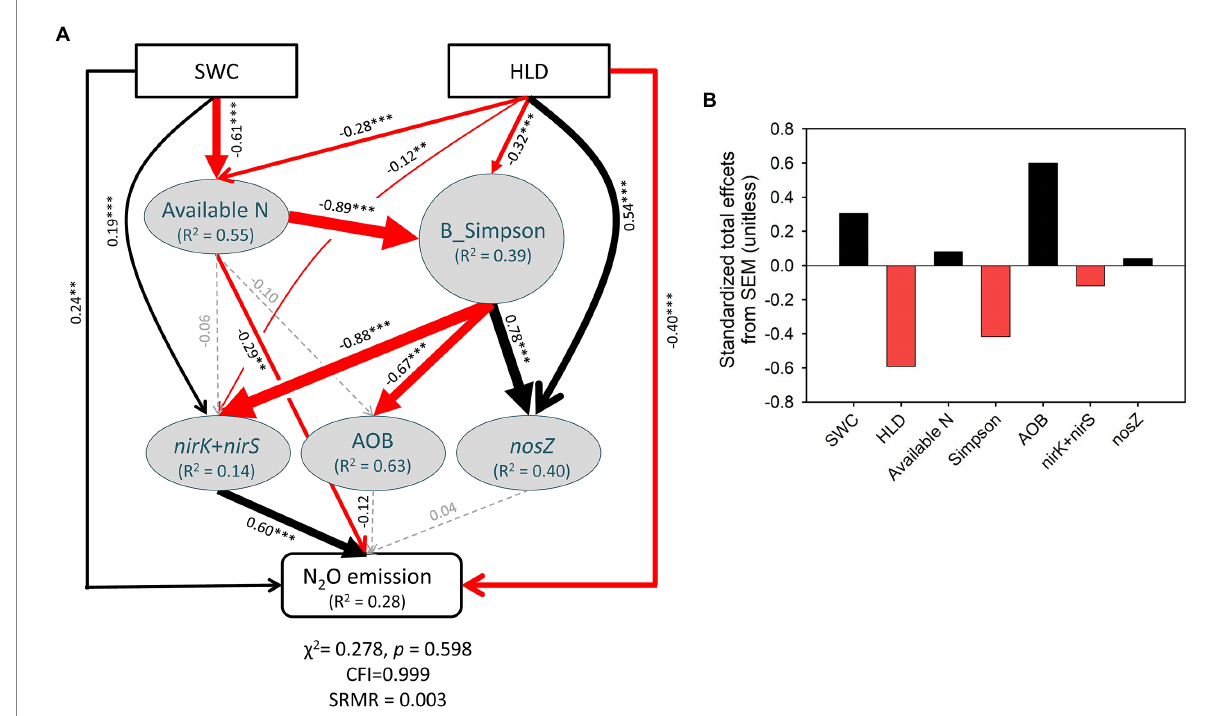
FIGURE 7 Structural equation modeling (SEM, A ) depicting the direct and indirect effects of soil water content (SWC) and hyphal length density (HLD) on the N 2 O emission of soil, and standardized total effects (direct plus indirect effects, B ) of the precipitation, AMF, available N, Bacterial Simpson, and N cycle relative genes on the resistance of N 2 O emission. Significant positive and negative paths ( p < 0.05) are shown as black and red arrows, respectively, and gray dashed arrows indicate nonsignificant pathways ( p > 0.05). * p < 0.05, ** p < 0.01, and *** p <